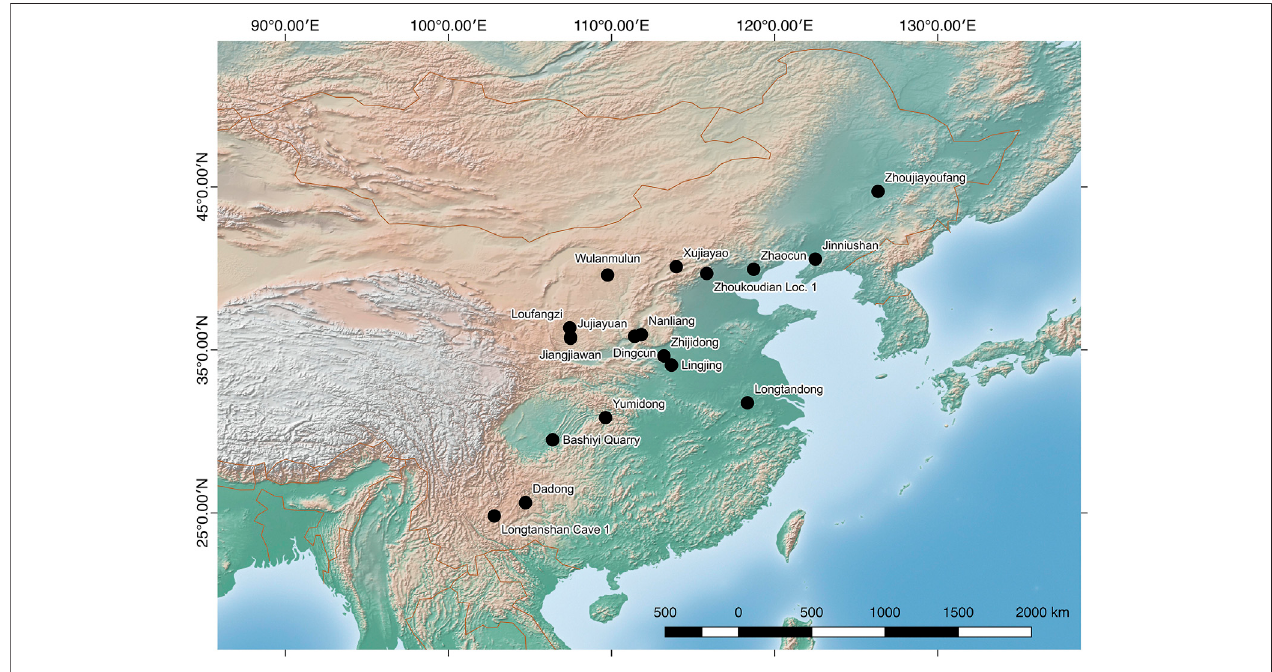
FIGURE2| DistributionofChineseMiddlePaleolithicsiteswhereosseoustechnologywasreportedintheliterature(see Table1 fordetails).MapmadebyLDusing QGIS v. 2.14.3-Essen (Free Software Foundation, Inc., Boston) and free vector and raster from Natural Earth (naturalearthdata.com).